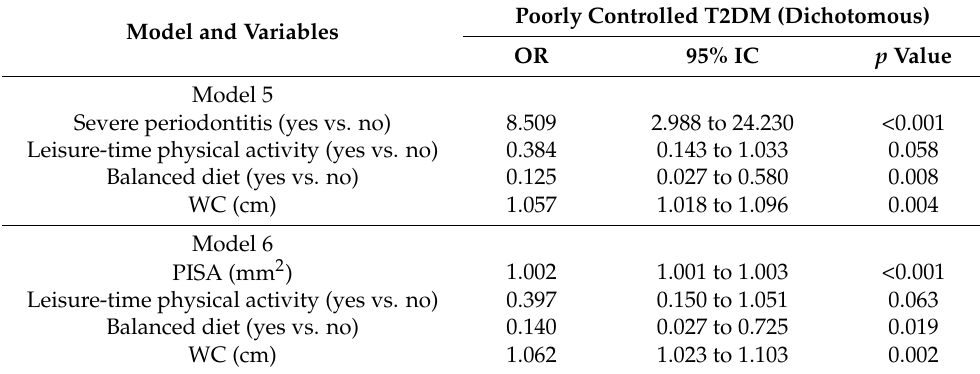
Table 4. Association between poorly controlled T2DM and severe periodontitis. Model and